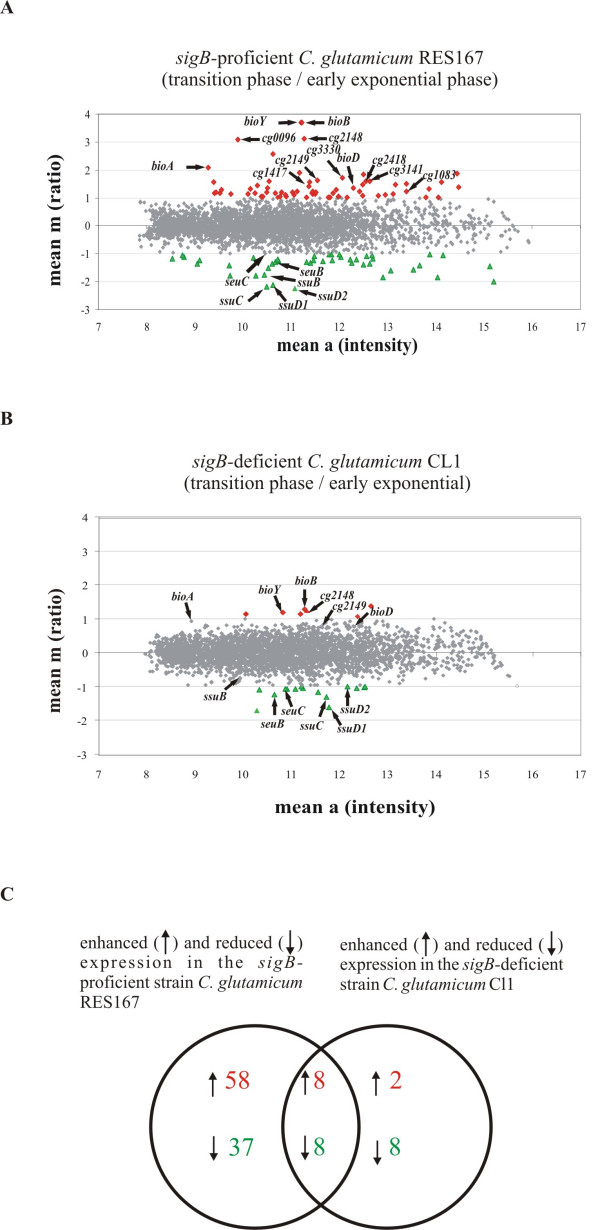
Identification of SigB-dependent genes by DNA microarray hybridization. Ratio/intensity (m/a) plots of DNA microarray hybridizations of sigB-proficient C. glutamicum RES167 (A) and sigB-deficient C. glutamicum CL1 (B) comparing genome-wide transcription at transition phase with that at early exponential phase. Diamonds represent genes with enhanced mRNA levels during transition phase; triangles represent genes with decreased mRNA levels. Each data point was calculated as the average of two biological and two technical replicates including dye-swapping. Selected genes, which were discussed in the text, are indicated (C) The diagram shows the numbers of genes with enhanced and reduced expression during transition phase in the sigB-proficient strain C. glutamicum RES167 (left), the sigB-deficient strain C. glutamicum CL1 (right) and in both strains (middle).